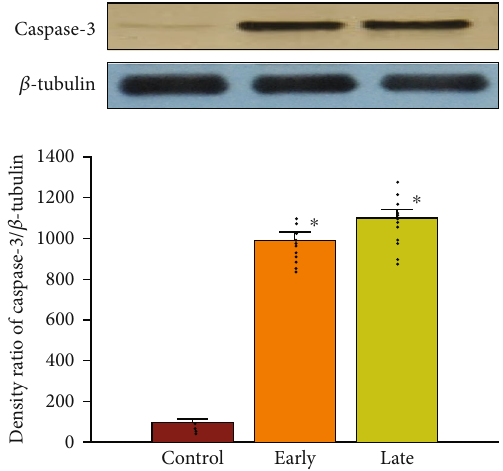
Figure 5: Prenatal opioid exposure enhanced the level of the caspase-3 expression in the ventral-medial striatum of neonatal rat o ff spring on P14. The level of cleaved caspase-3 in the ventral- medial striatum of neonatal rat o ff spring from morphine-addicted mothers is summarized in three groups as follows: the control group ( n = 12 rats), the early group ( n = 12 rats), and the late group ( n = 12 rats), respectively. The upper panel reveals illustrative immunoblots. β -Tubulin was used as an internal standard control and was not signi fi cantly di ff erent across lanes. Scatted dots represent the data points in each group. ∗ p < 0 : 05 , compared to the control group. # p < 0 : 05 , compared to the early